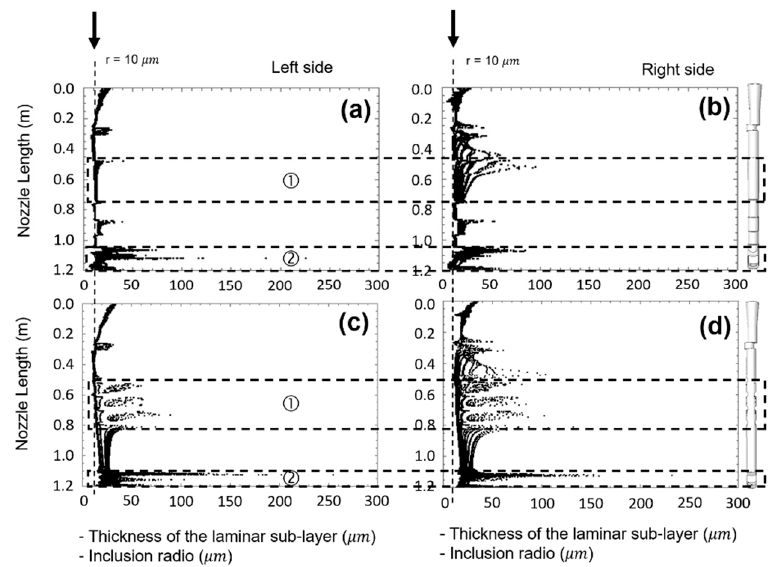
Figure 9. Thickness of the laminar sub-layer as function of the nozzle Length for ( a) ,( b ) Nozzle A and ( c) ,( d ) Nozzle